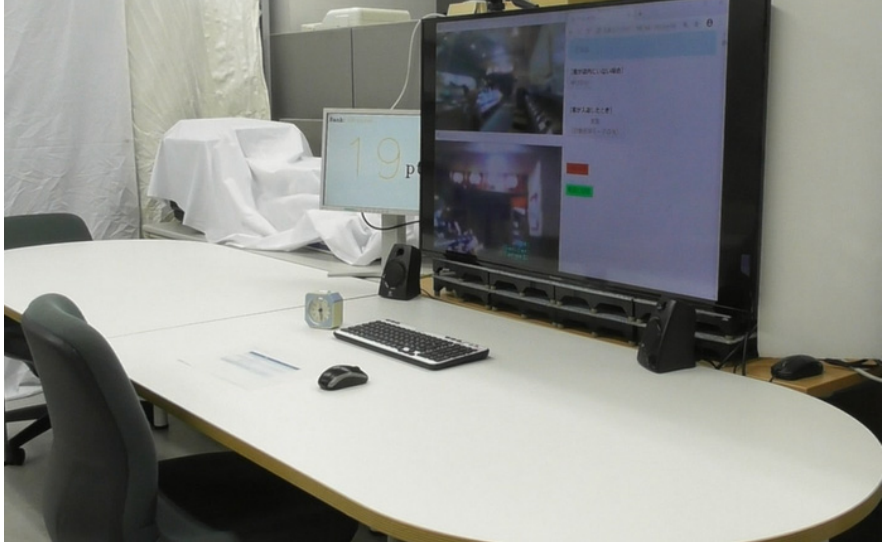
Figure 20. Experimental environment.